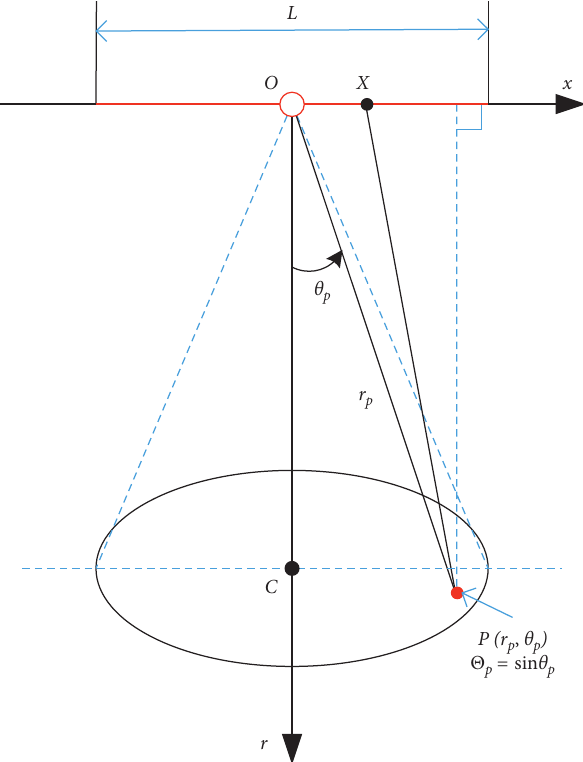
Figure 1: Imaging geometry for spotlight SAR in polar